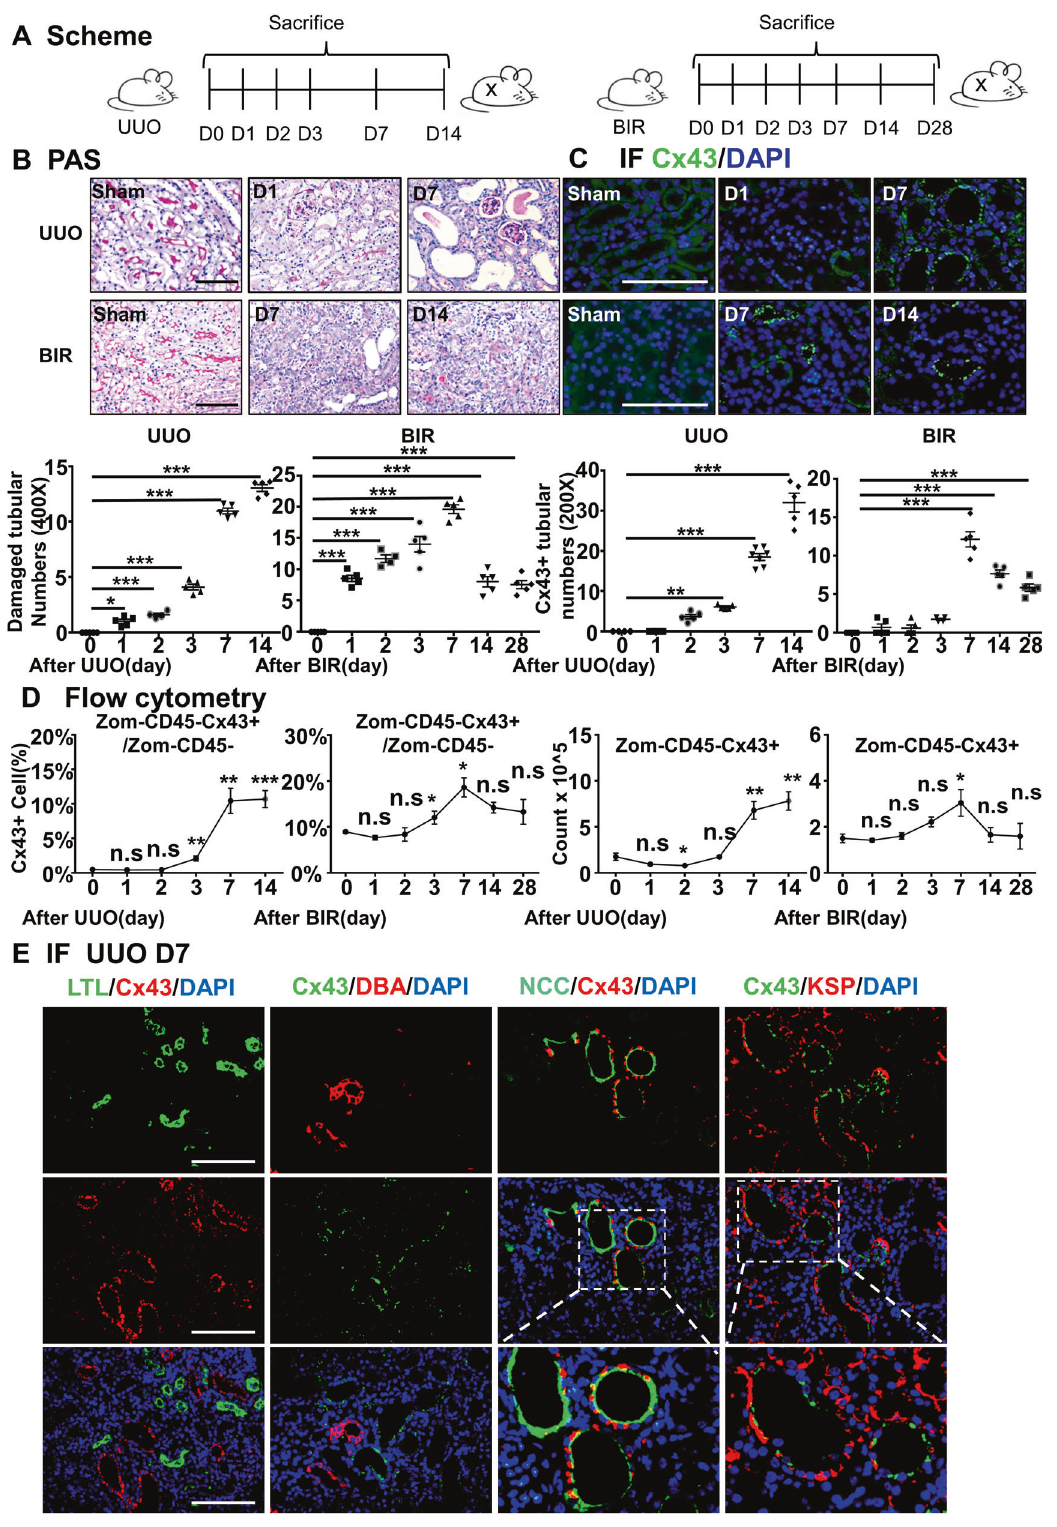
Fig. 1 The expression of Cx43 correlates with the severity of kidney injury. A Scheme. time-related comparison after UUO and BIR. B PAS staining. PAS staining was executed to evaluate renal tubular injury by calculating damaged tubules. C Immuno fl uorescence. Cx43-positive tubules were counted at different points. D The percentage (left) and number (right) of Cx43-positive tubules analyses by fl ow cytometry from the whole kidneys. E Immuno fl uorescence. The immuno fl uorescence co-staining of NCC (a collecting tubule cells speci fi c marker), KSP (a renal tubular epithelial cell-speci fi c marker), LTL (a proximal tubule cells speci fi c marker) or DBA (a distal tubule cells speci fi c marker) with Cx43. Data are presented as the mean ± SEM, n = 4 – 7/group, * P < 0.05, ** P < 0.01, *** P < 0.001; Scale bar: 100 μ m.